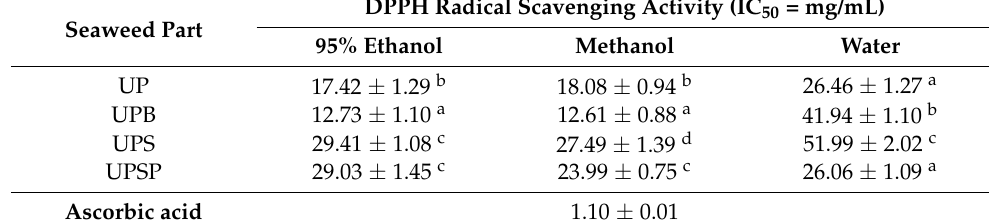
Table 2. DPPH half-maximal inhibitory concentration (IC 50 ) of different solvent extracts of different parts of Undaria pinnatifida